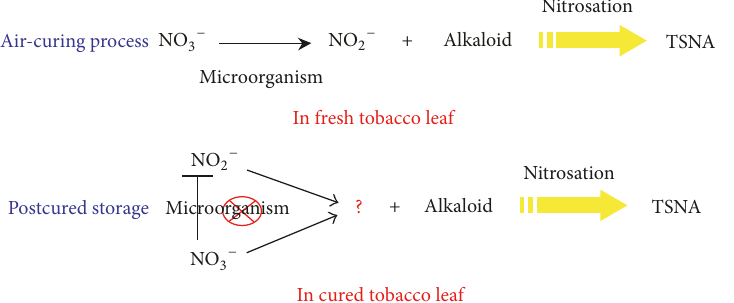
Figure 2: The activated nitrosating agents participate in nitrosation of alkaloid to form TSNAs during different processes of air-cured tobacco production. Nitrate (NO 3− ) is available for reduction to nitrite (NO 2− ) via microbial activity, and the nitrite, in turn, becomes involved in nitrosation reactions with the alkaloids during air-curing, leading to the formation of TSNAs. The nitrite is the most important nitrosating agent during air-curing. TSNAs formation was almost not influenced by microorganism during the storage